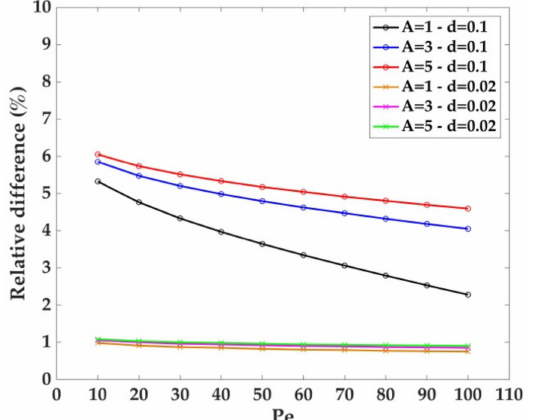
Figure 3. Mesh convergence criterion. Relative difference in electrodic dimensionless current compared with the most accurate d = 0.01 du taken as reference. Five channel heights were considered, namely A = 1, 2, 3, 4, and 5 du. The mesh size d = 0.02 du significantly reduced the discrepancy in current values with the reference mesh size d = 0.01 du, if compared with the less accurate mesh size d = 0.1